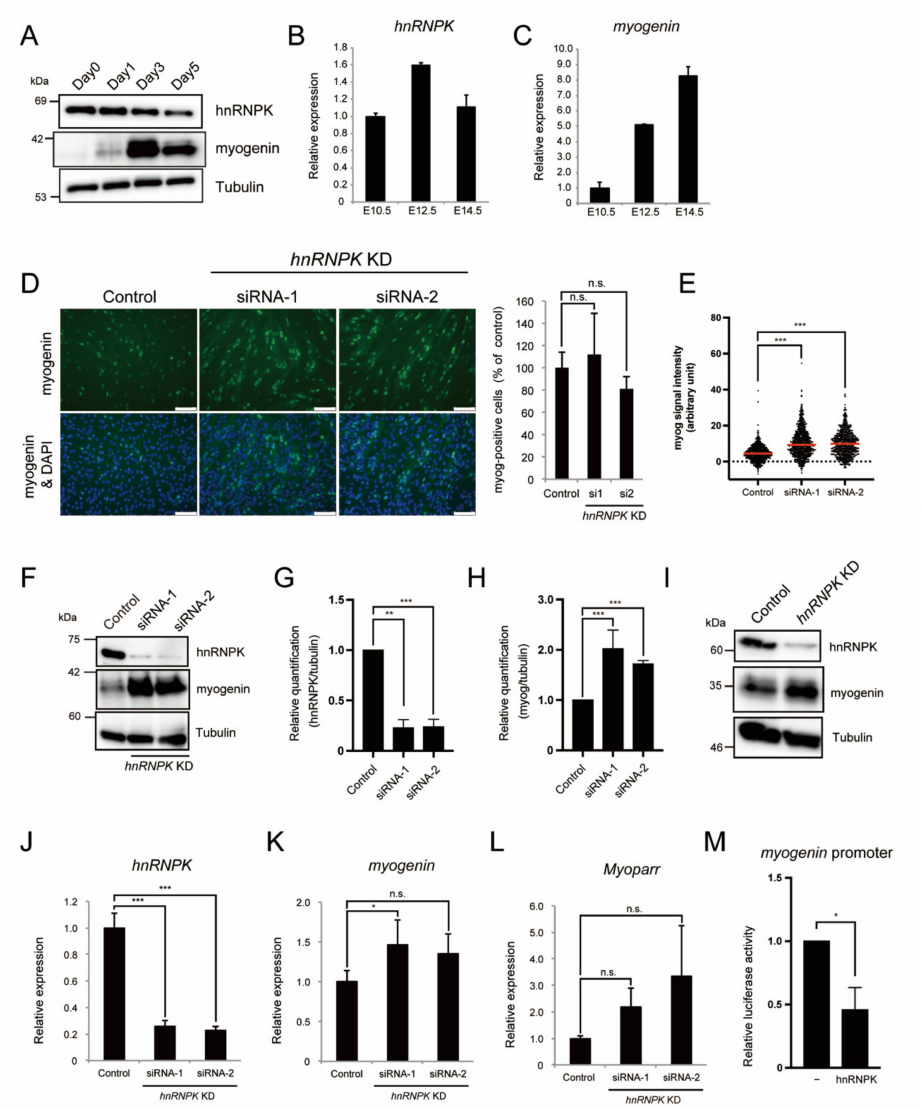
Figure 2. hnRNPK represses the expression of myogenin at the transcriptional level. ( A ) Western blots showing the hnRNPK and myogenin expression during C2C12 differentiation. The tubulin expression served as an internal control. ( B , C ) Quantitative RT–PCR for hnRNPK ( B ) and myogenin ( C ) during myogenesis in mouse embryonic skeletal muscle. The x-axis shows embryonic days. n = 3, mean ± SD. ( D ) Immunocytochemistry for myogenin 48 h after hnRNPK KD in C2C12 cells. Nuclei were counterstained with DAPI. Bar, 100 µ m. The percentage of the myogenin-positive cells is shown as the percentage of the control. n = 4, mean ± SD. n.s., not significant. ( E ) The results of the cell count based on the signal intensity of immunocytochemistry for myogenin of ( D ). The red line indicates the median. Nine image fields were counted per sample. Control; n = 824, hnRNPK siRNA-1; n = 859, hnRNPK siRNA-2; n = 761. *** p < 0.001. A Mann–Whitney nonparametric test was used for comparisons between each group. ( F ) Western blots showing increased myogenin expression in differentiating C2C12 cells 48 h after hnRNPK KD. Blots are representative of four repeats. ( G , H ) Relative quantification of hnRNPK ( G ) and myogenin ( H ) from ( F ). n = 4, mean ± SD. *** p < 0.001, ** p < 0.01. ( I ) Increased myogenin expression in differentiating mouse primary myoblasts 48 h after hnRNPK KD. Blots are representative of three repeats. ( J – M ) Quantitative RT-PCR to detect the expression of hnRNPK ( J ), myogenin ( K ), and Myoparr ( L ) after hnRNPK knockdown. n = 3–4, mean ± SD. *** p < 0.001, * p < 0.05, n.s., not significant. ( M ) Exogenous hnRNPK decreased the promoter activity of myogenin in differentiating C2C12 cells. n = 3, mean ± SD. * p <